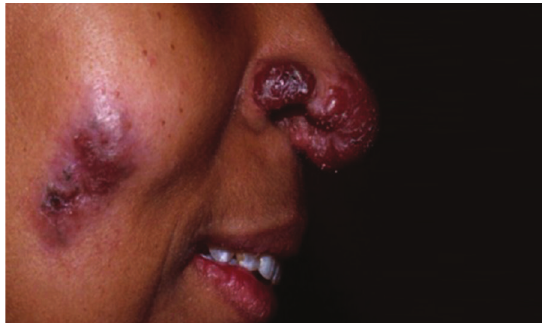
Figure 3 - Chronic cutaneous sarcoidosis